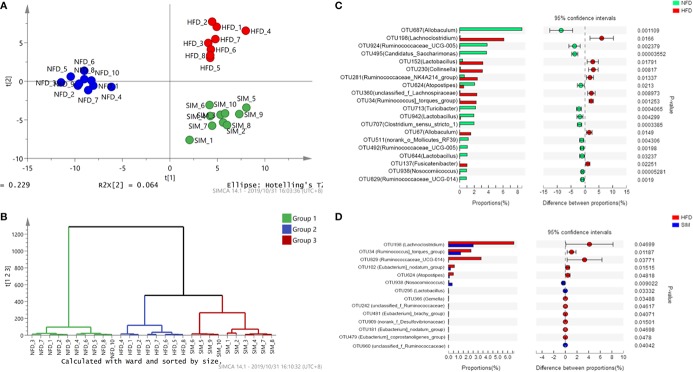
The overall structural changes of the gut microbiota were analyzed among different groups. (A) Principal component analysis and (B) hierarchical clustering tree analysis. Extended error bar plot comparing the differences in the mean proportions of the significantly altered intestinal microbial phylotypes. (C) NFD group versus HFD group, (D) SIM group versus HFD group.